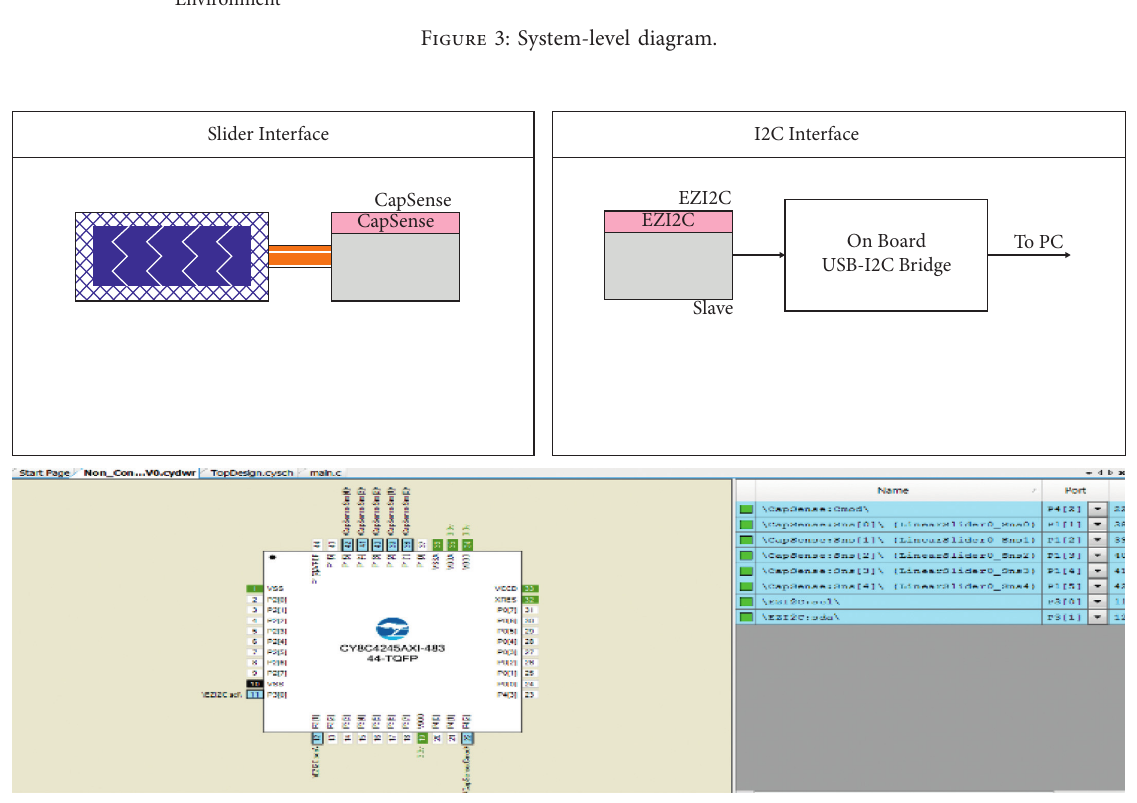
Figure 4: Top design and pin mapping.